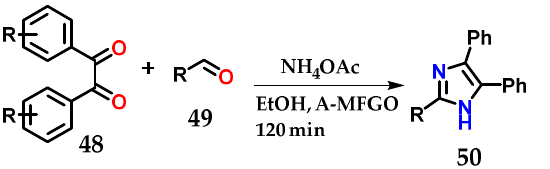
Figure 21. Obtaining 2,4,5-trisubstituted imidazoles 50 from the coupling of substituted 1,2-diphenylethane-1,2-dione (benzyl) 48 , substituted aldehydes 49 and NH 4 OAc using A-MFGO as a catalyst.